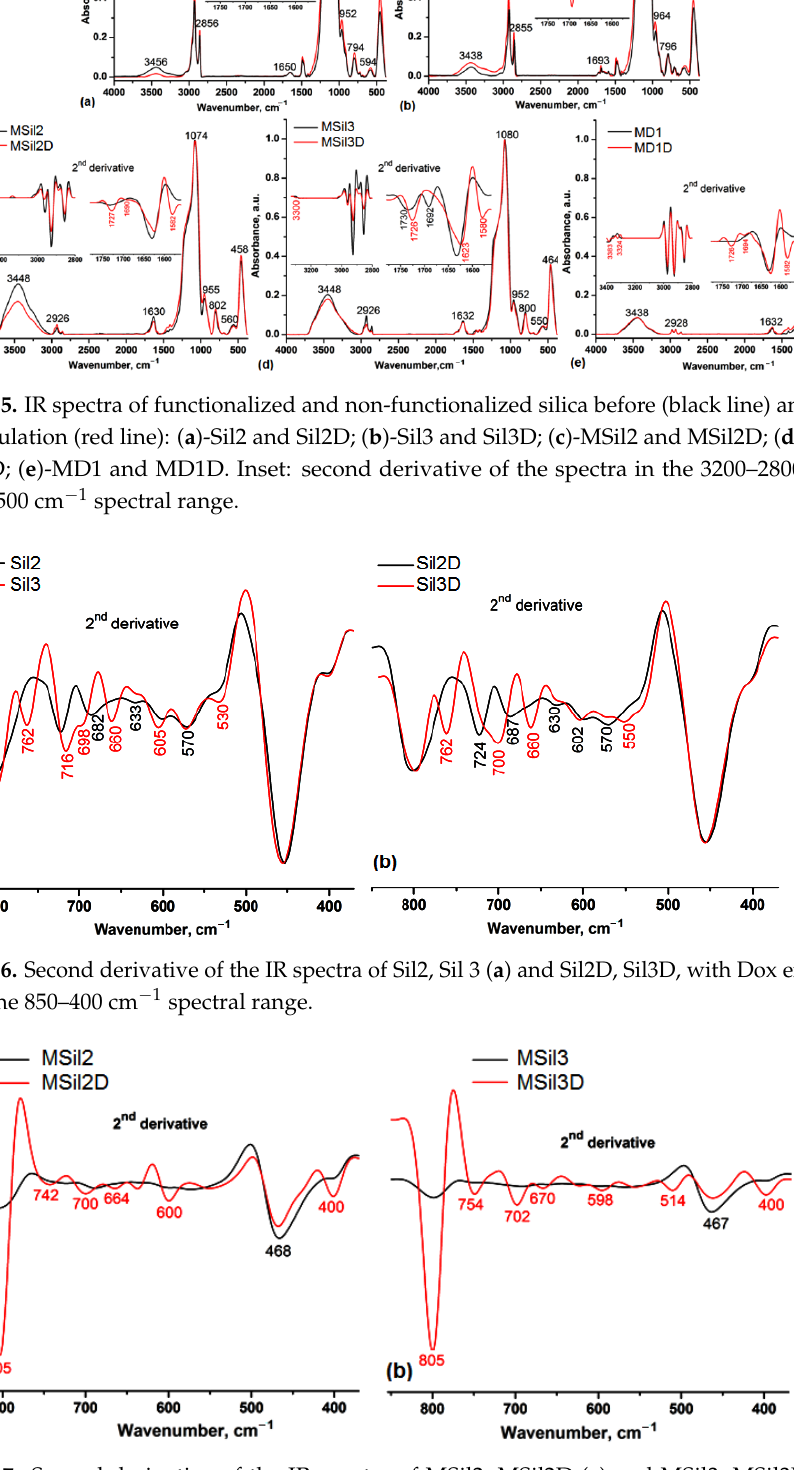
Figure 7. Second derivative of the IR spectra of MSil2, MSil2D ( a ) and MSil3, MSil3D ( b ) in the 850– 400 cm −1 spectral range (The codes of the Dox-loaded samples contain “D” letter).